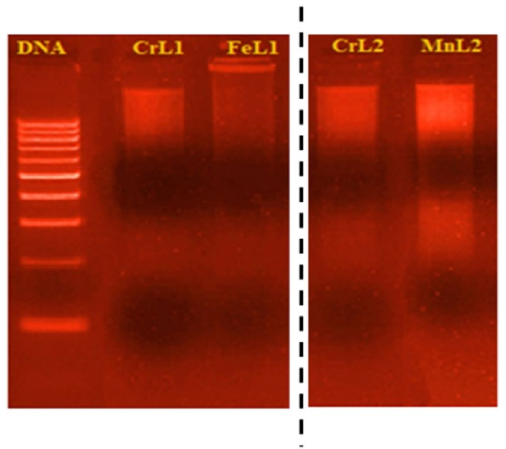
Figure 13. The cropped gel electrophoresis photograph demonstrating the new complexes’ interaction with CT-DNA during binding. DNA ladder in lane 1, CrL1 and DNA in lane 2, FeL1 and DNA in lane 3, CrL2 and DNA in lane 4, and MnL2 and DNA in lane